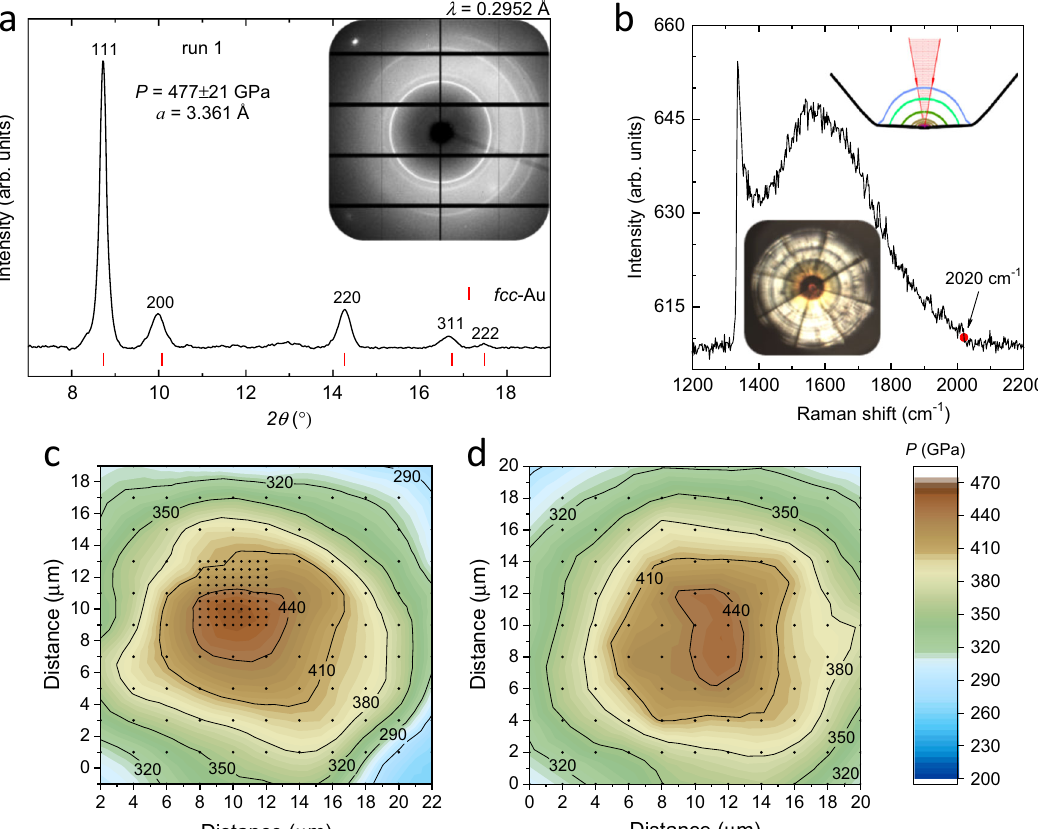
Fig. 1 | X-ray diffraction and Raman measurements for the diamond edge Raman scale. a X-ray powder diffraction pattern of gold in run 1 at the maximum pressure value of 477±21GPa. Red ticks indicate the calculated positions of gold. Theinsetshowstheoriginaldiffractionpattern. b Ramanspectrumrecordedinrun 1 at the same pressure. The Raman band (1333cm − 1 – 2020cm − 1 ) is formed by the response of the whole stressed volume of the diamond anvil starting from the signaloftheunstresseddiamondinsidetheanviltothesignalofthediamondculet, wheretheRamanshiftismaximum.Ithasacutoffinformofstep,amidpointatthe step is at ∼ 2020cm − 1 . The signal is excited by the focused laser (red arrows) as